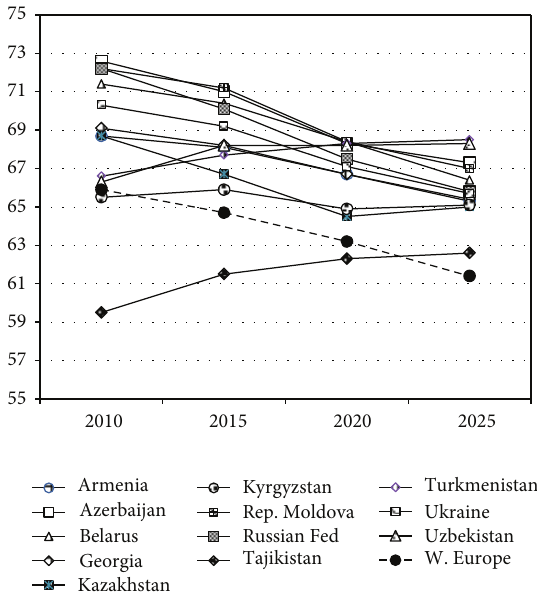
F 4: Changes in the size of the 15–64-years-old population,